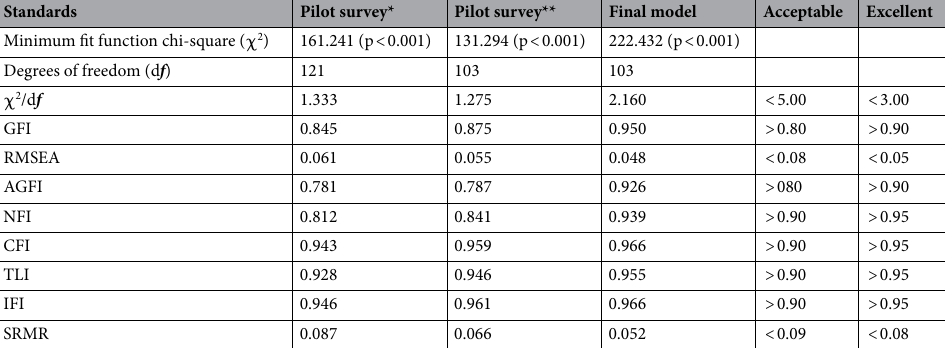
Table 6. Modified model fit of both the pilot and final questionnaire survey. *indicates the results of the factor analysis after removing the question “I think the social robot is also paying attention to my actions when I interact with it”. **indicates the results of the factor analysis after deleting the question “I think social robots have a hard time understanding my